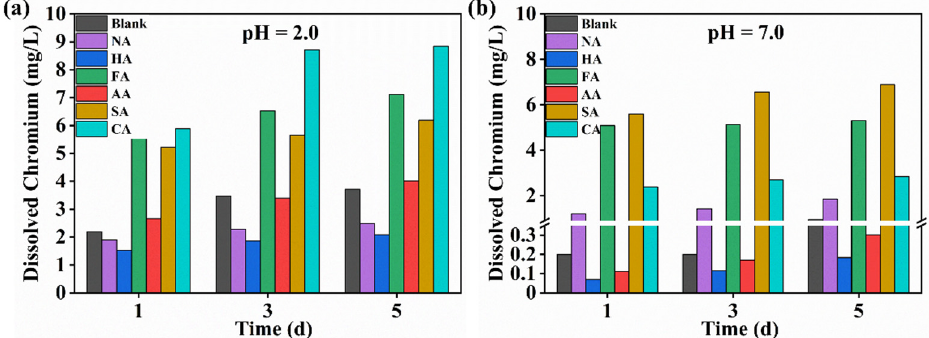
Figure 6. Variation in dissolved chromium ions with time for the blank sample and MIL-101 (Cr, Sn) synthesized with different modulators at different pH solutions; ( a ) pH 2, ( b ) pH 7.